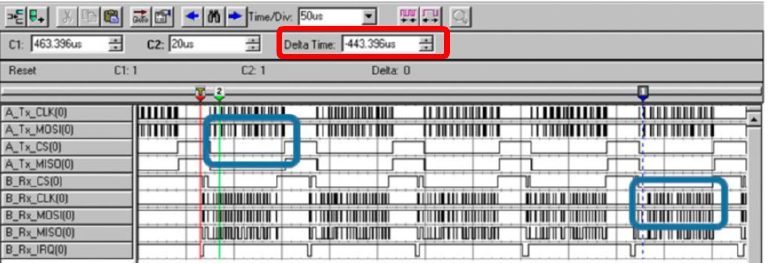
Figure 6. Capture of the transmission and reception between Transmitter and Receiver devices. Blue boxes show correspondent frames in transmission and reception, and the red box highlights the delay between